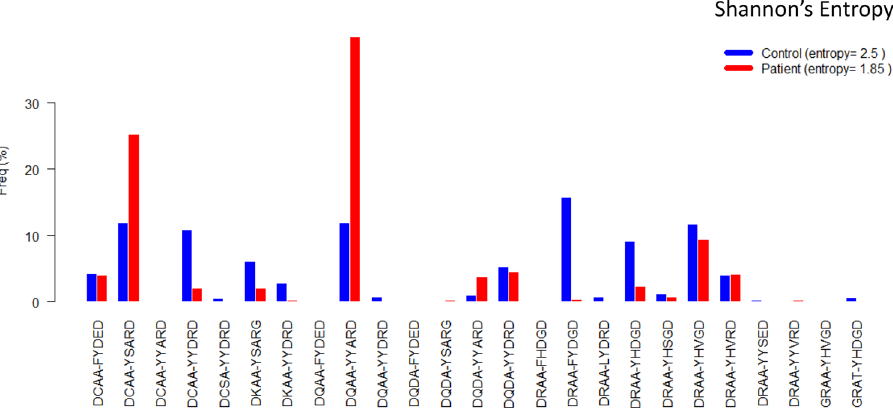
Figure 3. Frequencies of all DQ motifs among 636 controls and 962 patients involved in BDD